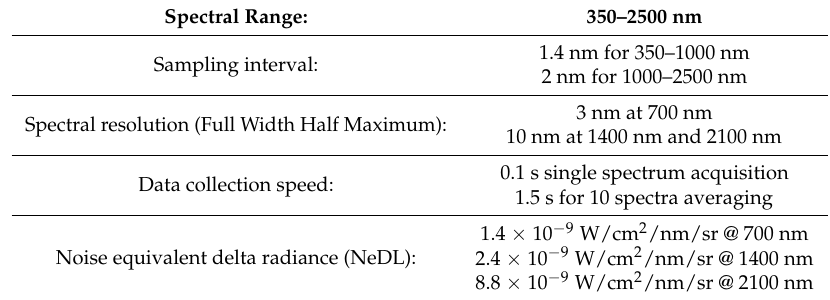
Table 1. Technical specification of an ASD FieldSpec 3 spectrometer (www.asdi.com, Boulder, CO, USA).